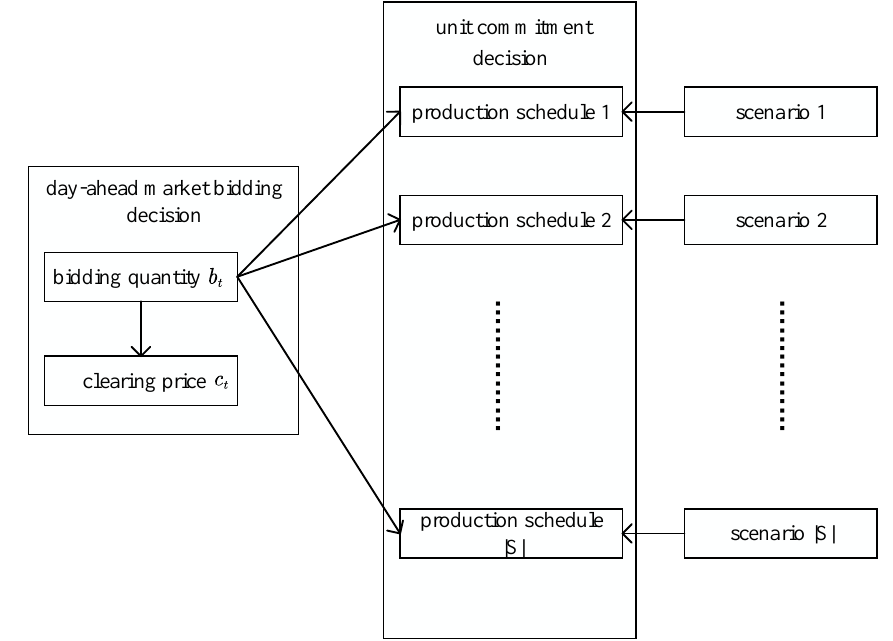
Figure 3. The process of two ‐ stage decision ‐ making.